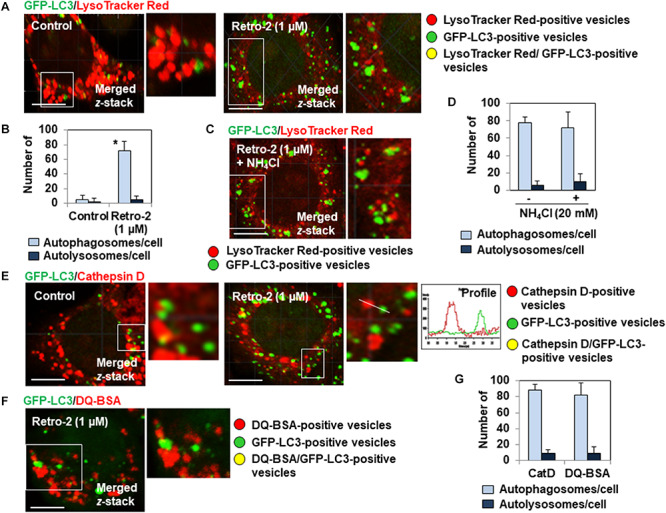
Retro-2 impairs the formation of autolysosomes. (A) A representative CLSM micrograph showing the presence of LysoTracker Red-positive vesicles (lysosomes), the rare presence of small GFP-LC3-positive vesicles (autophagosomes), and the absence of GFP-LC3/LysoTracker Red-positive vesicles (autolysosomes) in a control cell. A representative CLSM micrograph showing the presence of lysosomes, the elevated presence of very large autophagosomes, and the absence of autolysosomes in a Retro-2-treated cell (1 μM, 4 h of treatment). (B) Graph bar of quantification of numbers of autophagosomes/cell and autolysosomes/cell in cells treated for 4 h with Retro-2 (1 μM). (C) A representative CLSM micrograph showing the presence of LysoTracker Red-positive vesicles and GFP-LC3-positive vesicles in a cell treated for 4 h with Retro-2 (1 μM) in the presence of NH4Cl (20 mM). (D) Graph bar of quantification showed the equal numbers of autophagosomes and the absence of autolysosomes in cells treated for 4 h with Retro-2 (1 μM) in the presence or not of NH4Cl (20 mM). (E) A representative CLSM micrograph showing the high number of autophagosomes and cathepsin D-positive lysosomes, and the absence of autolysosomes in a Retro-2-treated cell (1 μM, 4 h of treatment). Graph (Profile) showing the absence of colocalization of GFP-LC3 (Green) and Cathepsin D (Red) fluorescent signals measured along the white orientation bar. Pearson’s correlation coefficient was –0.26, indicative of the absence of fusion between autophagosomes and lysosomes. (F) A representative CLSM micrograph showing in a Retro-2-treated cell (1 μM, 4 h of treatment) loaded with DQ Red BSA (DeQuenched Bovine Serum Albumin), which emits red fluorescence when it is protease degraded, the presence of red fluorescent-positive vesicles and large GFP-LC3 dots cells, and the absence of vesicles showing a yellow fluorescence resulting of cocalization between DQ Red BSA fluorescence and GFP-LC3 fluorescence. (G) Graph bar of quantification in Retro-2-treated cells (4 h of treatment with 1 μM) of numbers of autophagosomes/cell and autolysosomes/cell assessed by observation of Cathepsin D immunolabeling and DQ Red BSA assay. CLMS micrographs are representative of two separate experiments in duplicate. Scale bar, 10 μm. White boxed regions delineate the areas shown in adjacent high-magnification images. Quantification was performed using ImageJ software by examining at least 25 cells per treatment condition in two separate experiments in duplicate. Values represent the average (±SEM). Data were analyzed using the unpaired Student t-test. *P < 0.01 compared to Control (D).